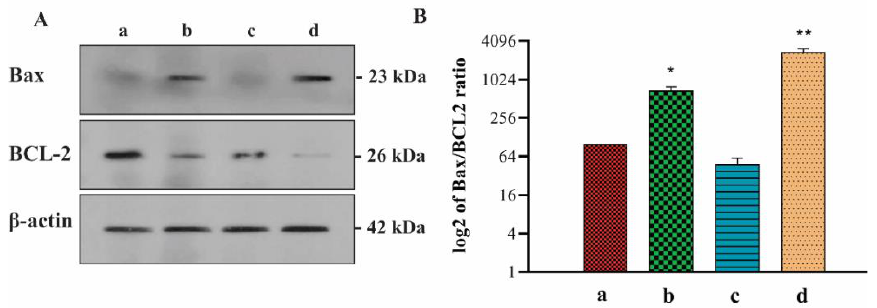
Figure 7. ( A ) Descriptive images of western blot analysis of Bax and Bcl-2 expression relative to β - actin as an internal control. ( B ) Bax/Bcl-2 ratio in A549 cell line treated with IC 50 concentrations of P. eldarica extracts and essential oil for 48 h. a. Control group, b. Pollen hexane extract-treated group (31.7 µg/mL), c. Bark essential oil-treated group (17.9 µg/mL), d. Methanolic needle extract-treated group (0.3 µg/mL). Data are expressed as mean ± standard deviation (SD), representative of three independent experiments. * p < 0.05 and ** p < 0.01 vs. control.